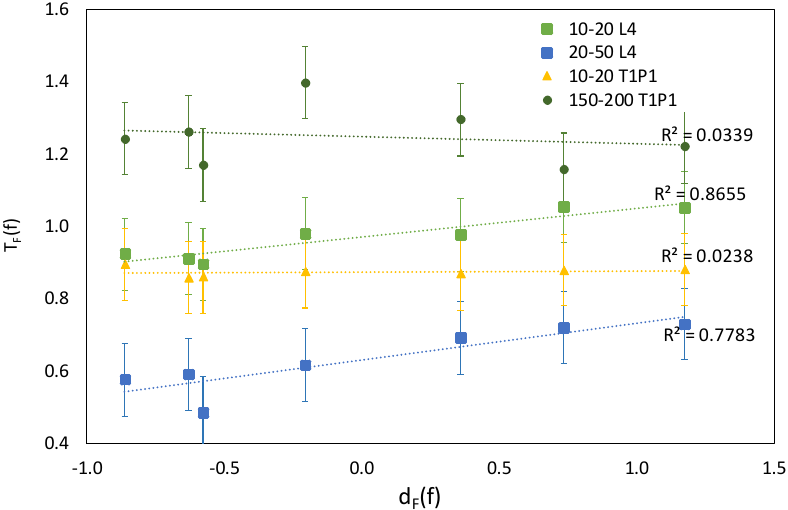
Figure 7. Correlation between the average discomfort and the average transmissibility. Points summa-